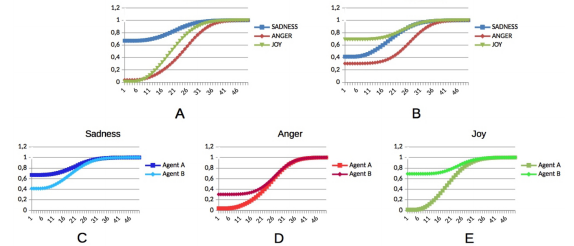
Fig. 3. Simulation results for pure amplification scenario with upwards tendency simulating three emotions SADNESS , ANGER and JOY : A) emotional dynamic of agent A , B) emotional dynamic of agent B , C) emotional dynamic of SADNESS on agents A and B , D) emotional dynamic of ANGER on agents A and B , and E) emotional dynamic of JOY on agents A and B. The horizontal axis denotes time elapsing in number of iterations and the vertical axis denotes emotional level. Notice how emotions tend to grow in time reaching its maximum.